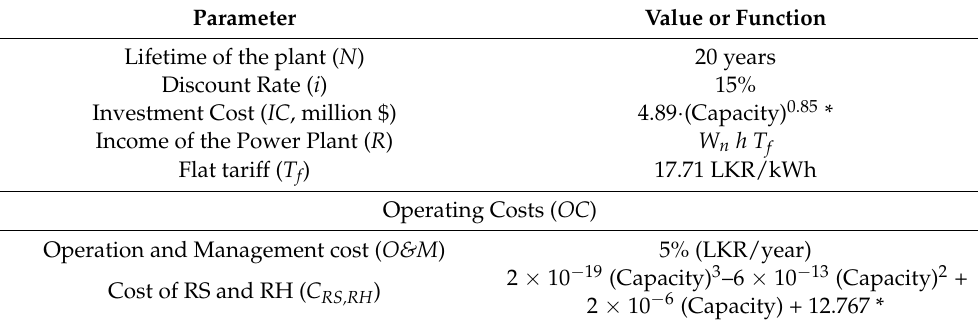
Table 1. Economic parameters with their relative values [7,10,34,35,42,46,47]. Parameter Value or